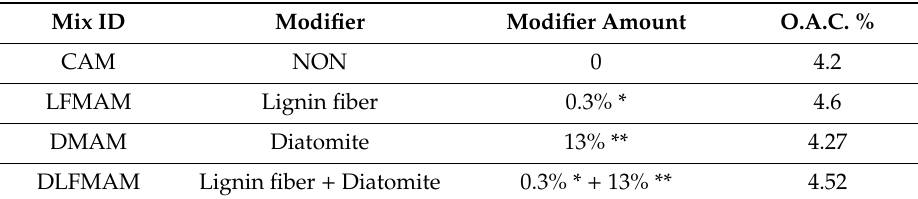
Table 6. Marshall Test values of asphalt